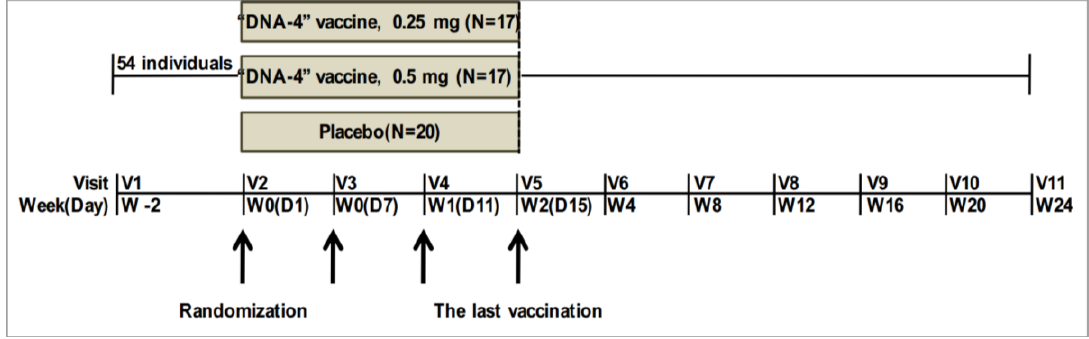
Figure 1. Trial scheme. Arrows show days of immunization.